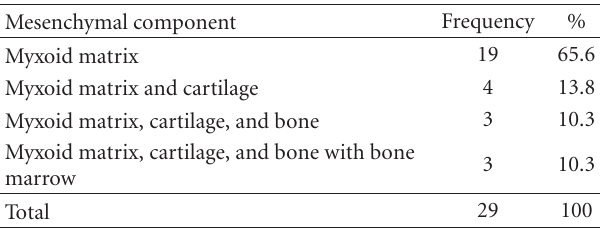
Table 5: Frequency of the tissue types observed in the stromal component of carcinoma in mixed tumor ( n = 29).